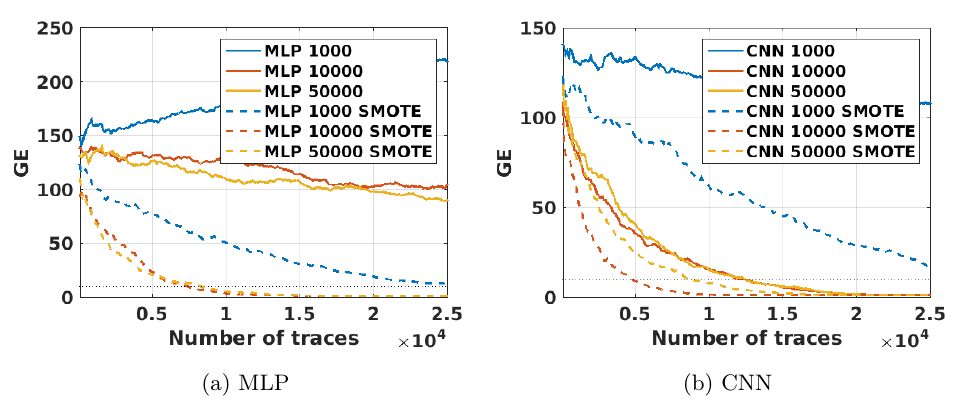
Figure 3: Guessing entropy for imbalanced and SMOTE on AES_HD, deep